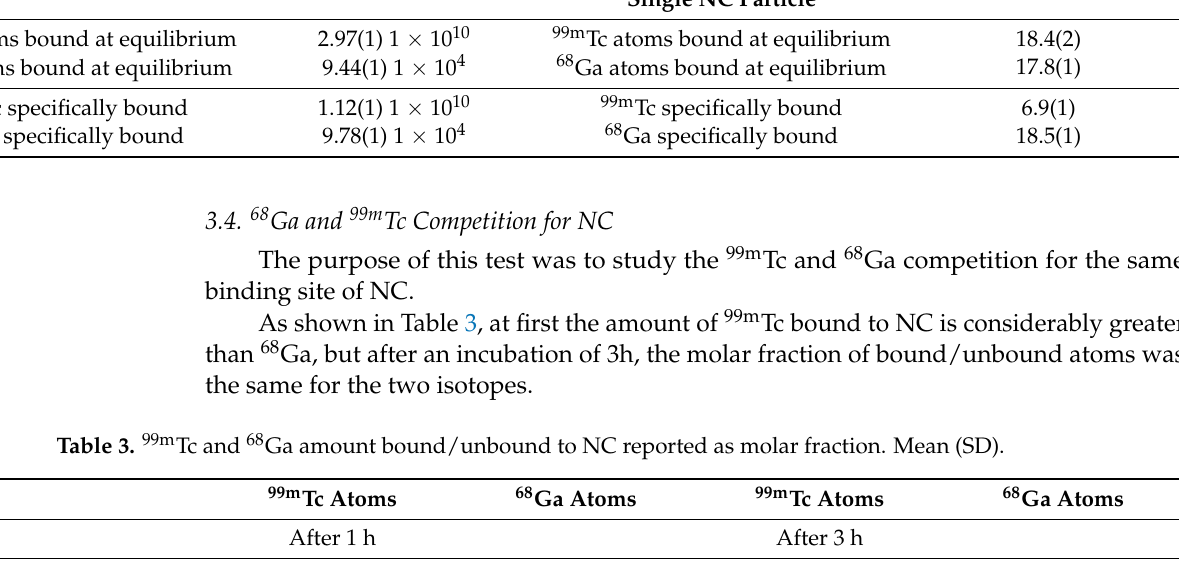
Table 3. 99m Tc and 68 Ga amount bound/unbound to NC reported as molar fraction. Mean (SD).